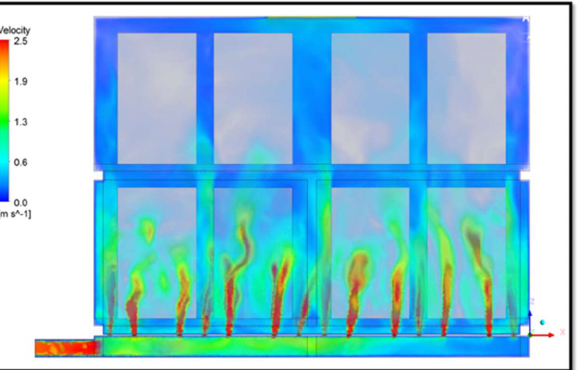
Figure 18. Air flow profile for the vented cooling design. An improved distribution of air can be seen in comparison to the profile shown in Figure 15.